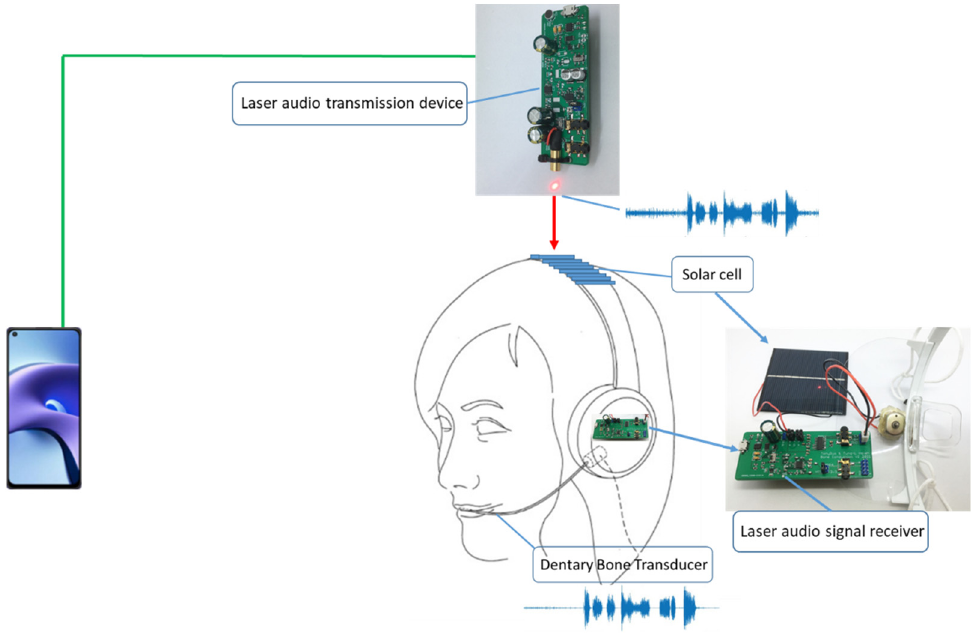
Figure 2. The schematic diagram of a dentary bone conduction system applied to humans. Table 1. The performance comparison of voice signal wireless transmission method. Table 2. The performance comparison between our dentary bone conduction device and other bone conduction